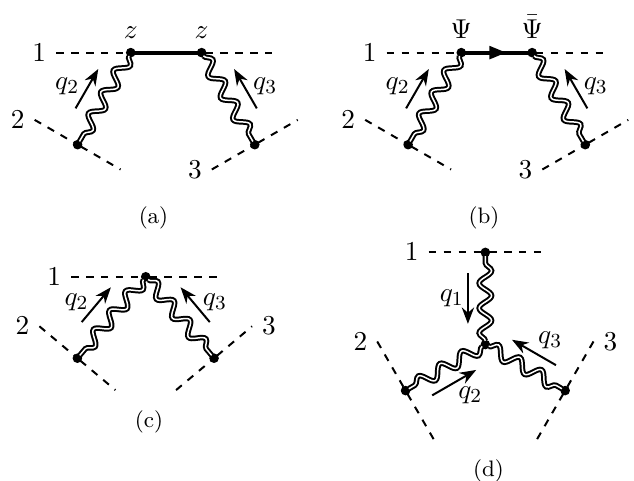
Figure 3 . The diagrams needed for the DG eikonal at NLO with three worldlines. For diagrams involving the propagators of Ψ 3b, we also need to include the crossed diagrams that can be obtained by simply reversing the arrows on the worldline. We only display diagrams with worldline propagator and contact interaction of particle